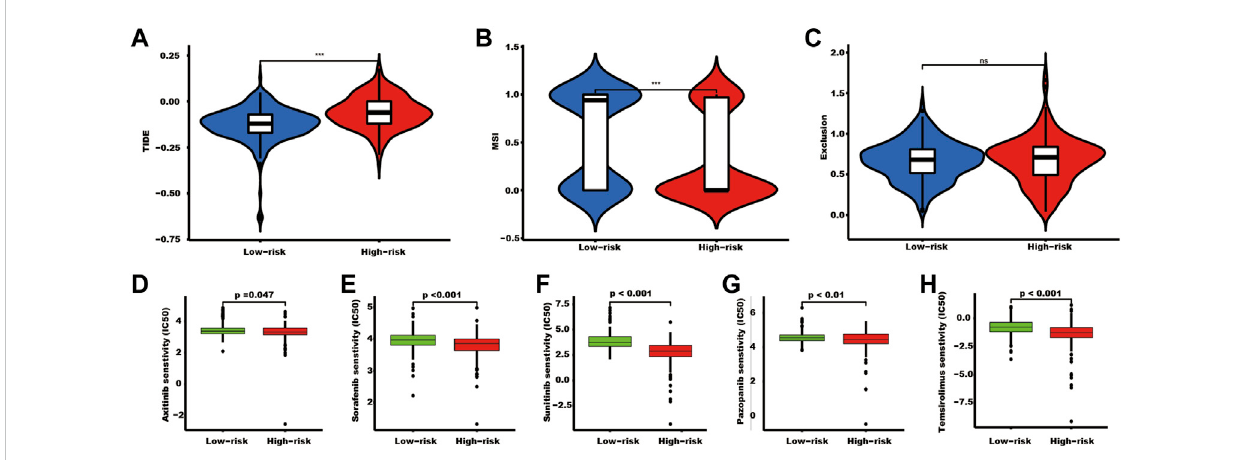
FIGURE 7 The TIDE score and targeted drug treatment sensitivity prediction in different risk groups. (A – C) TIDE, MSI, and exclusion scores of the two SUMOylation risk groups (*** indicates p < 0.001, ns indicates no signi fi cant difference). (D – H) Five targeted drugs half maximal inhibitory concentration